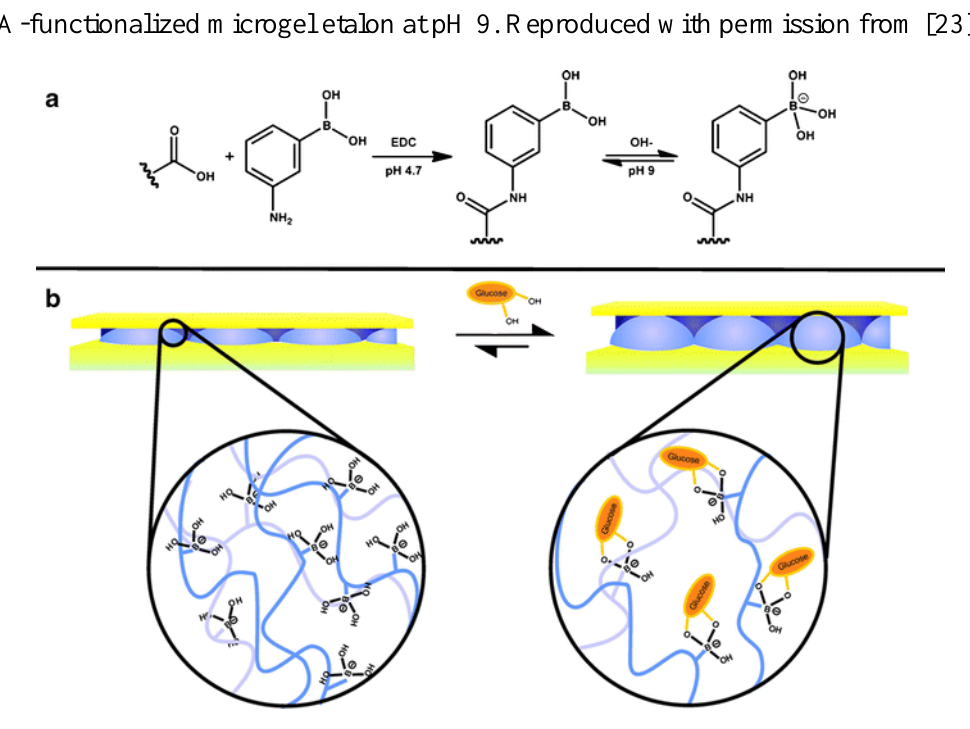
Figure 7. Polyelectrolyte penetration through the porous Au overlayer of an etalon. Reproduced with permission from